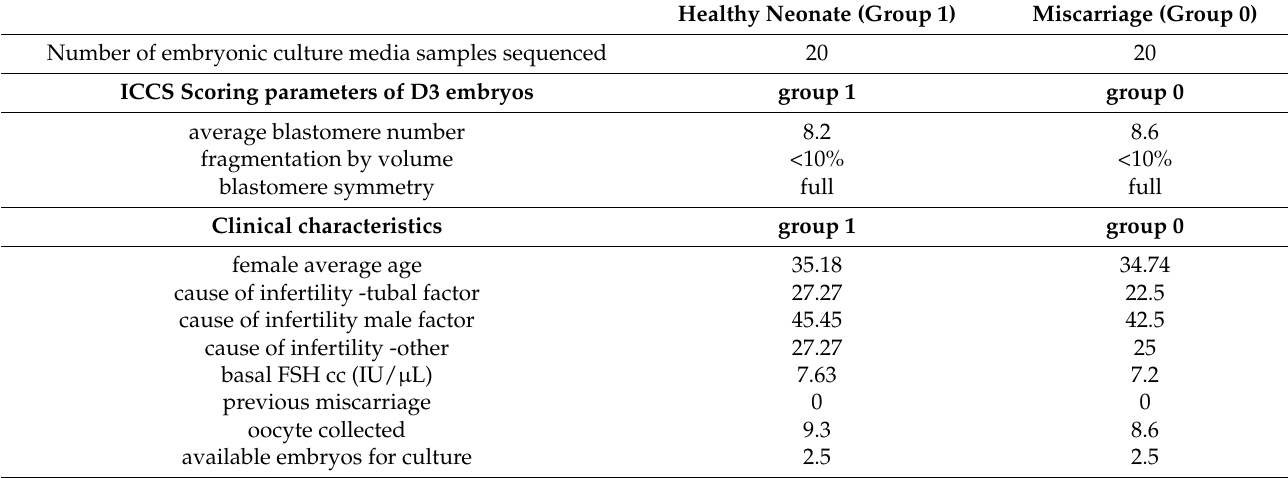
Table 4. Embryo morphology parameters and parental gynaecological characteristics. Healthy Neonate (Group 1) Miscarriage (Group